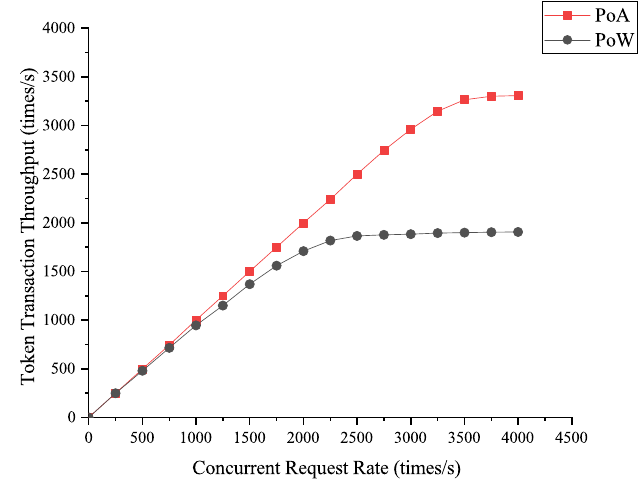
Figure 10. Token transaction throughput of PoA and PoW blockchain